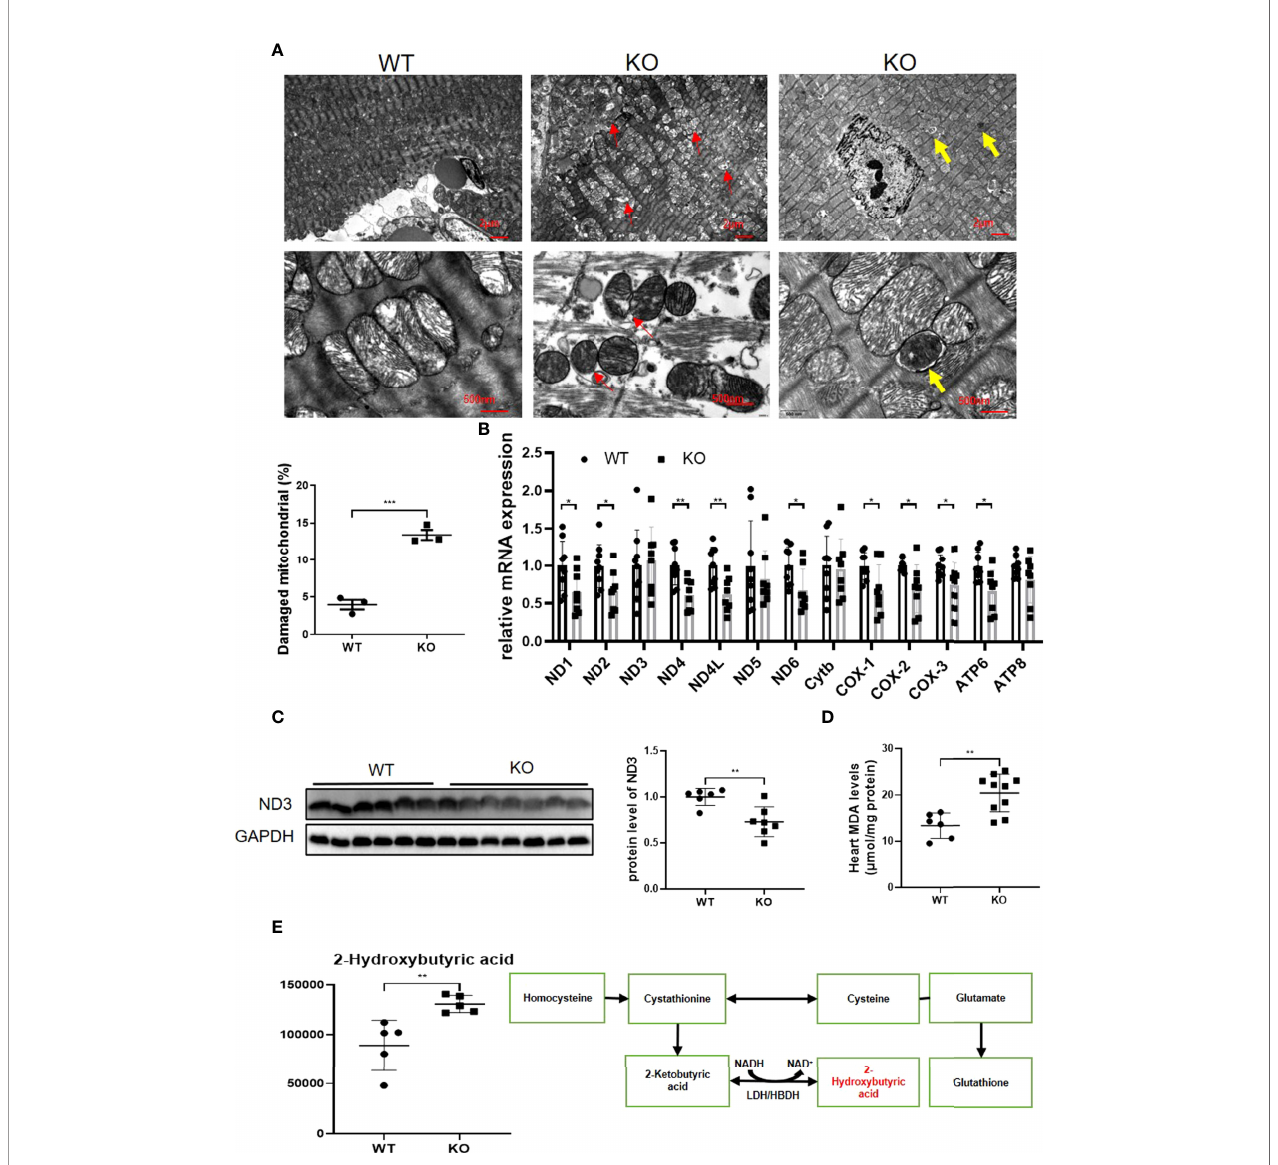
FIGURE 4 | MAVS deletion resulted in mitochondrial dysfunction by inducing oxidative stress and impaired mitophagy. (A) . Representative TEM images of hearts showed breaks in myocardial fi bers, mitochondrial disorganization, and mitophagy (Upper panel, scale bar: 2 µm; lower panel, scale bar: 500 nm; red circle: myocardial fi ber rupture; red arrow: damaged mitochondria; yellow arrow: autophagosomes containing mitochondrion). Quanti fi cation of damaged mitochondria in the hearts of MAVS-/- mice by TEM images (n: WT=3, KO=3). (B) , RT-qPCR analysis of mitochondrial genes in the hearts of WT and MAVS -/- mice (n: WT=9, KO=8). (C) . Western blotting analysis showed reduced expression of mitochondrial electron transfer chain protein ND3 in MAVS-/- mice. Densitometry analysis of the western blots of ND3 (n: WT=6, KO=7). (D) . Increased level of MDA was detected in MAVS -/- mice hearts (n: WT=6, KO=10). (E) . The level of 2-hydroxybutyric acid was markedly increased in the hearts of MAVS -/- mice (n: WT=5, KO=5). 2-Hydroxybutyric acid is a byproduct in the synthesis of glutathione in response to oxidative stress. The quantitative results are shown as the means ± SEM (*P < 0.05, **P < 0.01 and ***P <